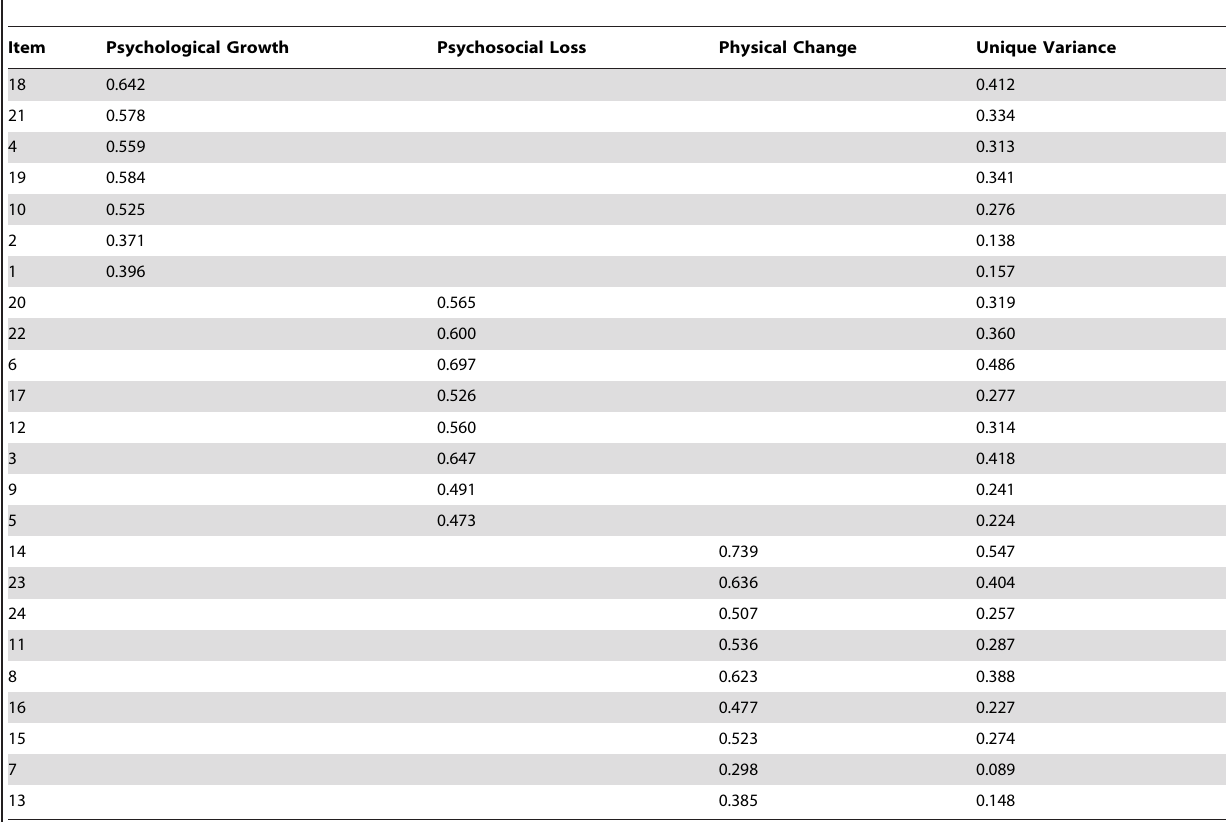
Table 5. Standardised regression weights of SINS-CN items on first-order factors and squared multiple correlations of error variances.